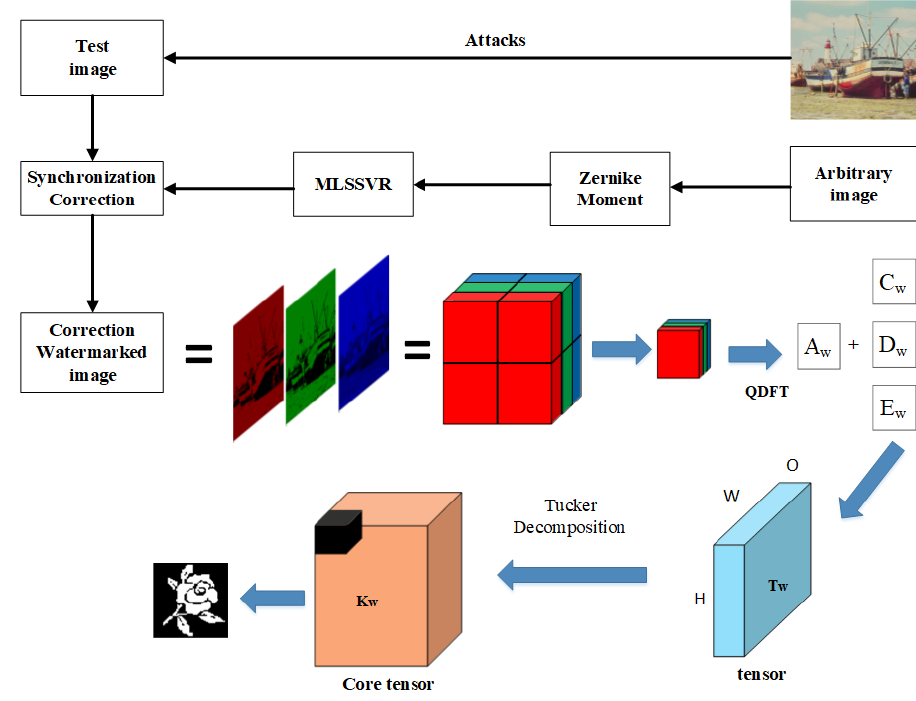
Figure 8. Flowchart for extracting